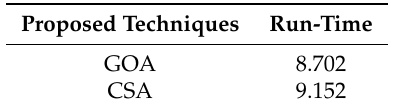
Table 3. GOA and CSA